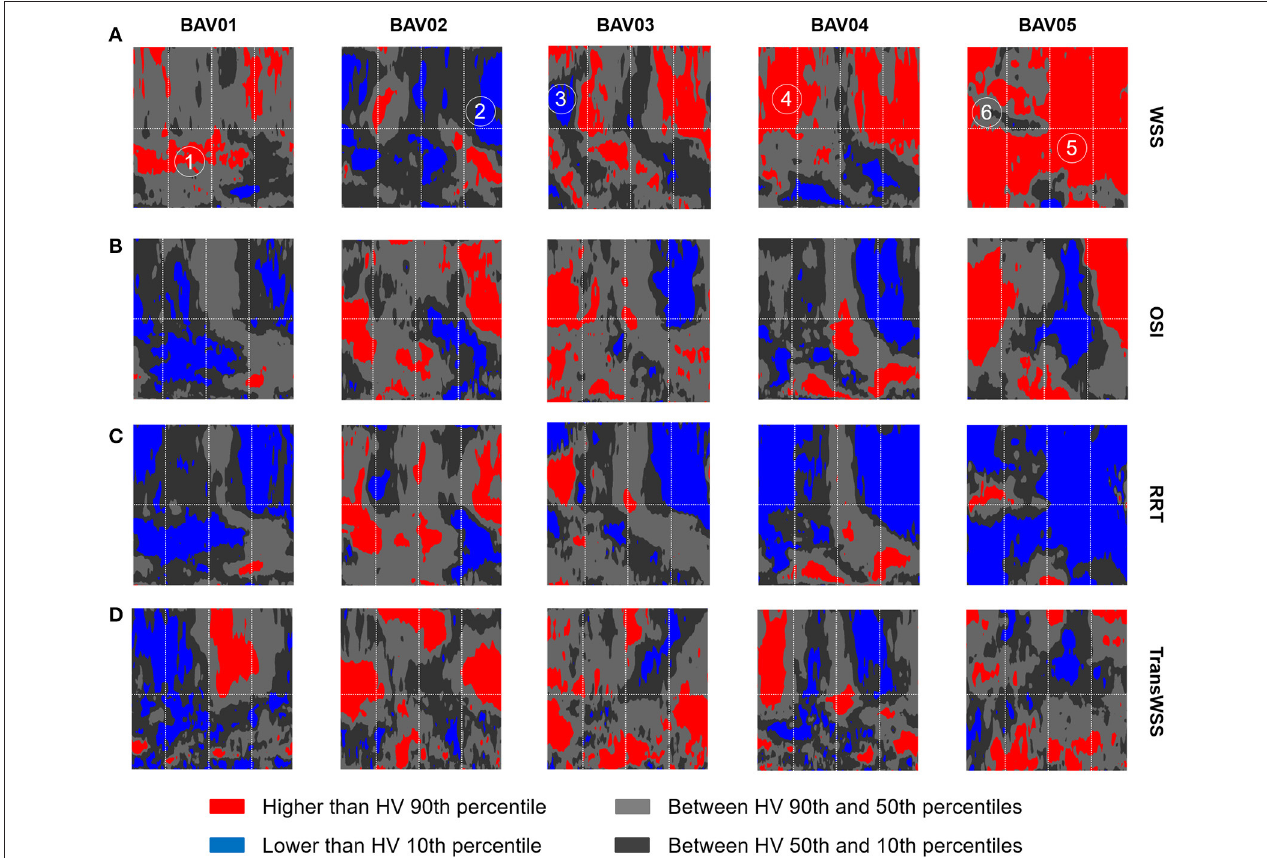
FIGURE 9 | Representation on the 2D template detailed in Figure 3 of the HV-relative heat maps of WSS (A) , OSI (B) , RRT (C) , and TransWSS (D) computed for each BAV patient. The HV-relative heat maps are obtained from point-wise comparison of each BAV patient against HVs population and color-coded accordingly: higher than 90th percentile (red), lower than 10th percentile (blue), between 90th and 10th percentiles (light gray, dark gray). On the HV-relative heat maps, six hot-spots were labeled and